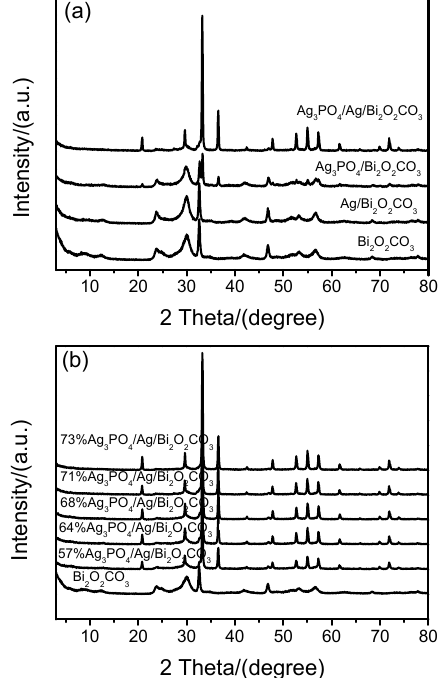
Figure 1. X ‐ ray diffraction (XRD) patterns of the different photo ‐ catalysts. ( a ) XRD of the different Figure 1. X-ray diffraction (XRD) patterns of the different photo-catalysts. ( a ) XRD of the different catalysts ( b ) XRD of the different amounts of Ag 3 PO 4 /Ag/Bi 2 O 2 CO 3 catalysts. catalysts ( b ) XRD of the different amounts of Ag 3 PO 4 /Ag/Bi 2 O 2 CO 3